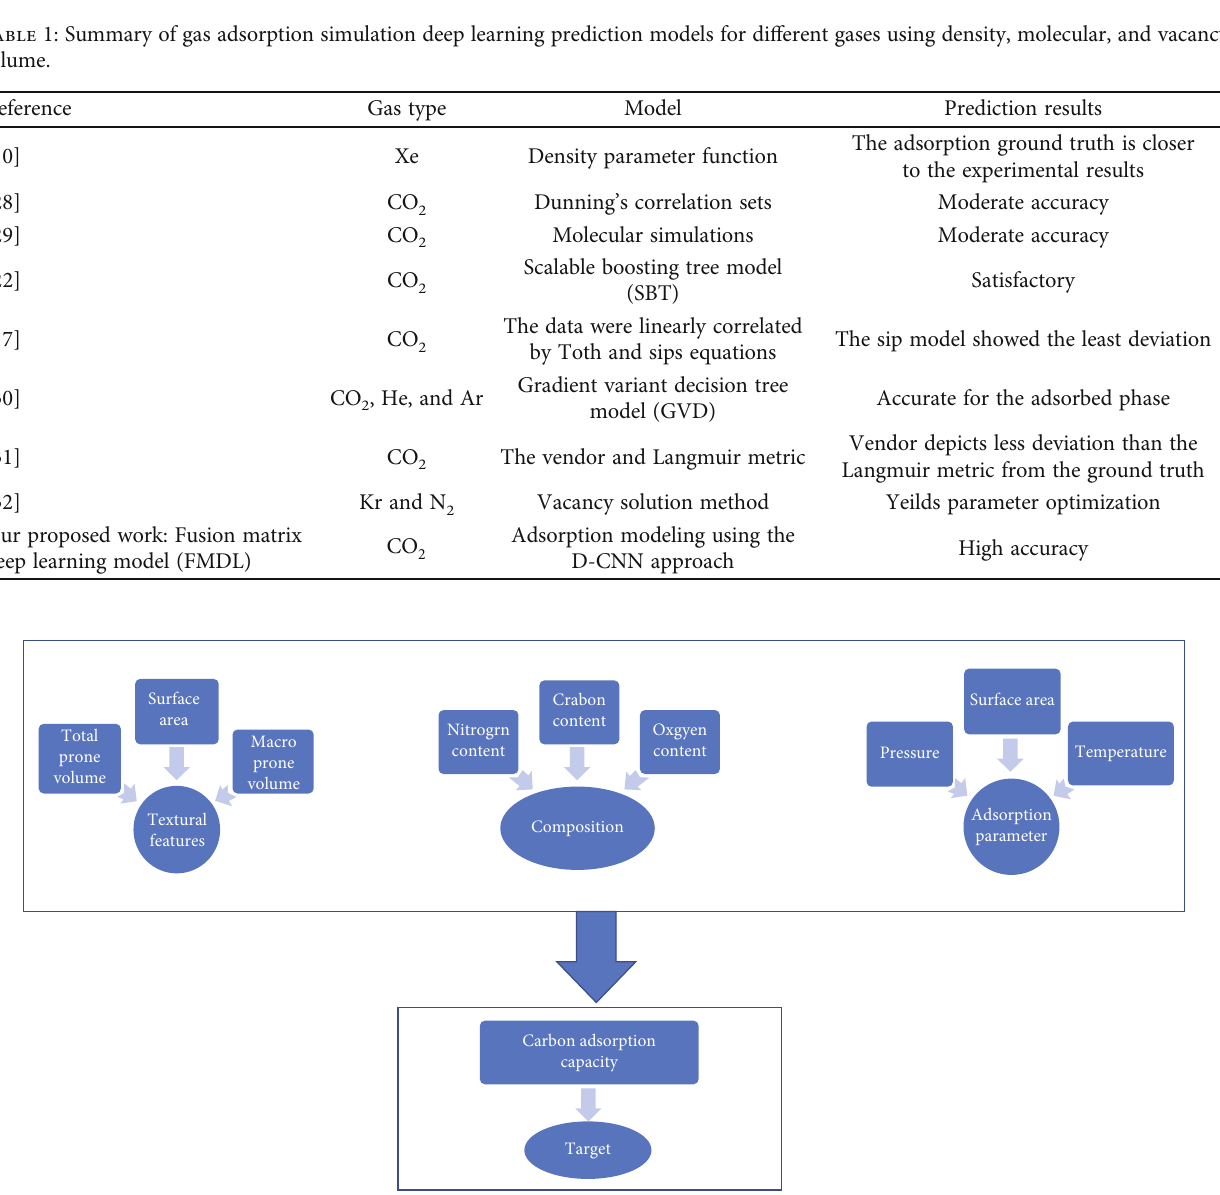
Figure 1: The proposed work fl ow de fi ning model parameters, namely, textural, composition, and adsorption